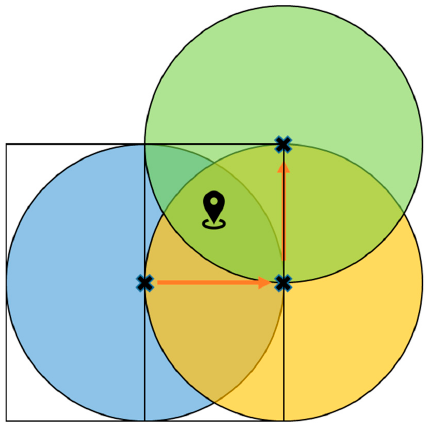
Figure 3. Schematic diagram of Space Partition Attack Algorithm. (Modified from [7]).